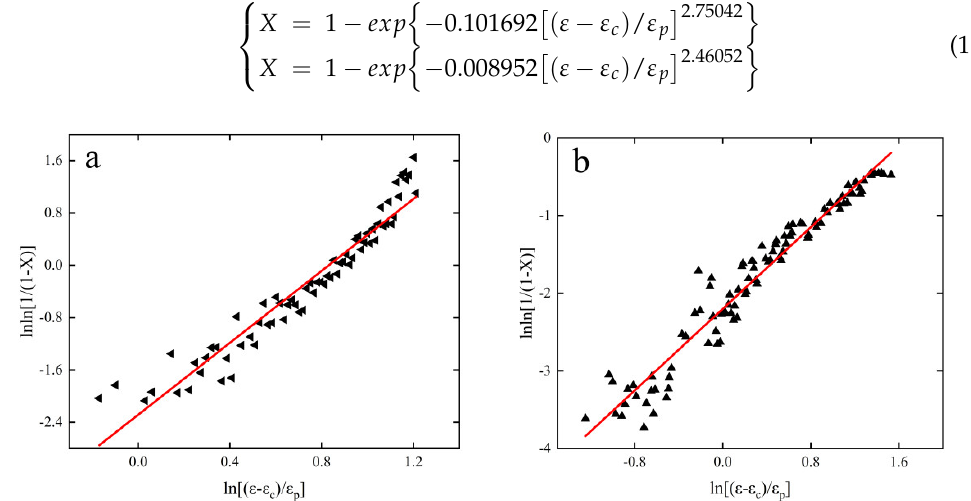
(cid:3) fit plots: ( a ) 0.01 S − 1 , ( b ) 10 S − 1 c ) / ε p